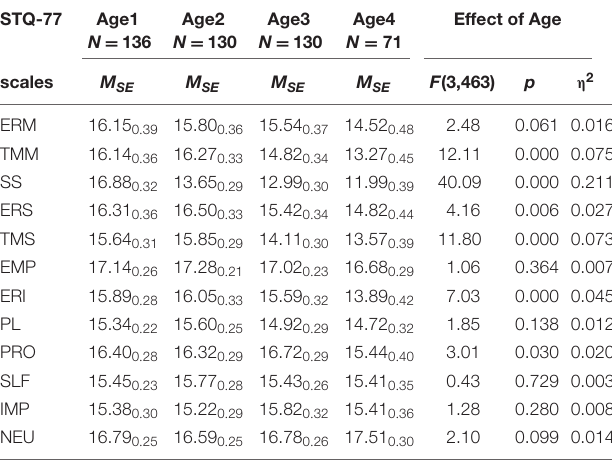
TABLE 3 | Means and Standard Error ( M SE ) on the STQ-77 scales for groups contrasted by Age, and the ANOVA effects. STQ-77